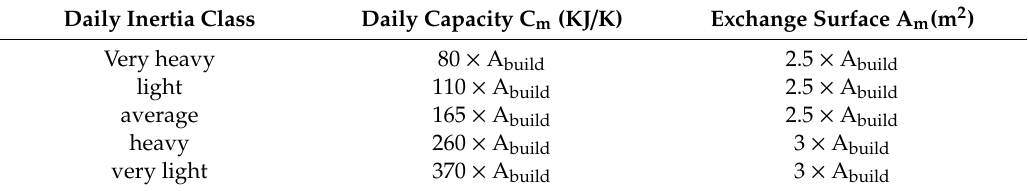
Table A2. Daily capacity.